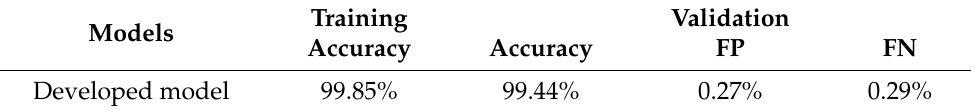
Table 6. Accuracy and false rates of reconstructing profiles by the developed framework (Type-II